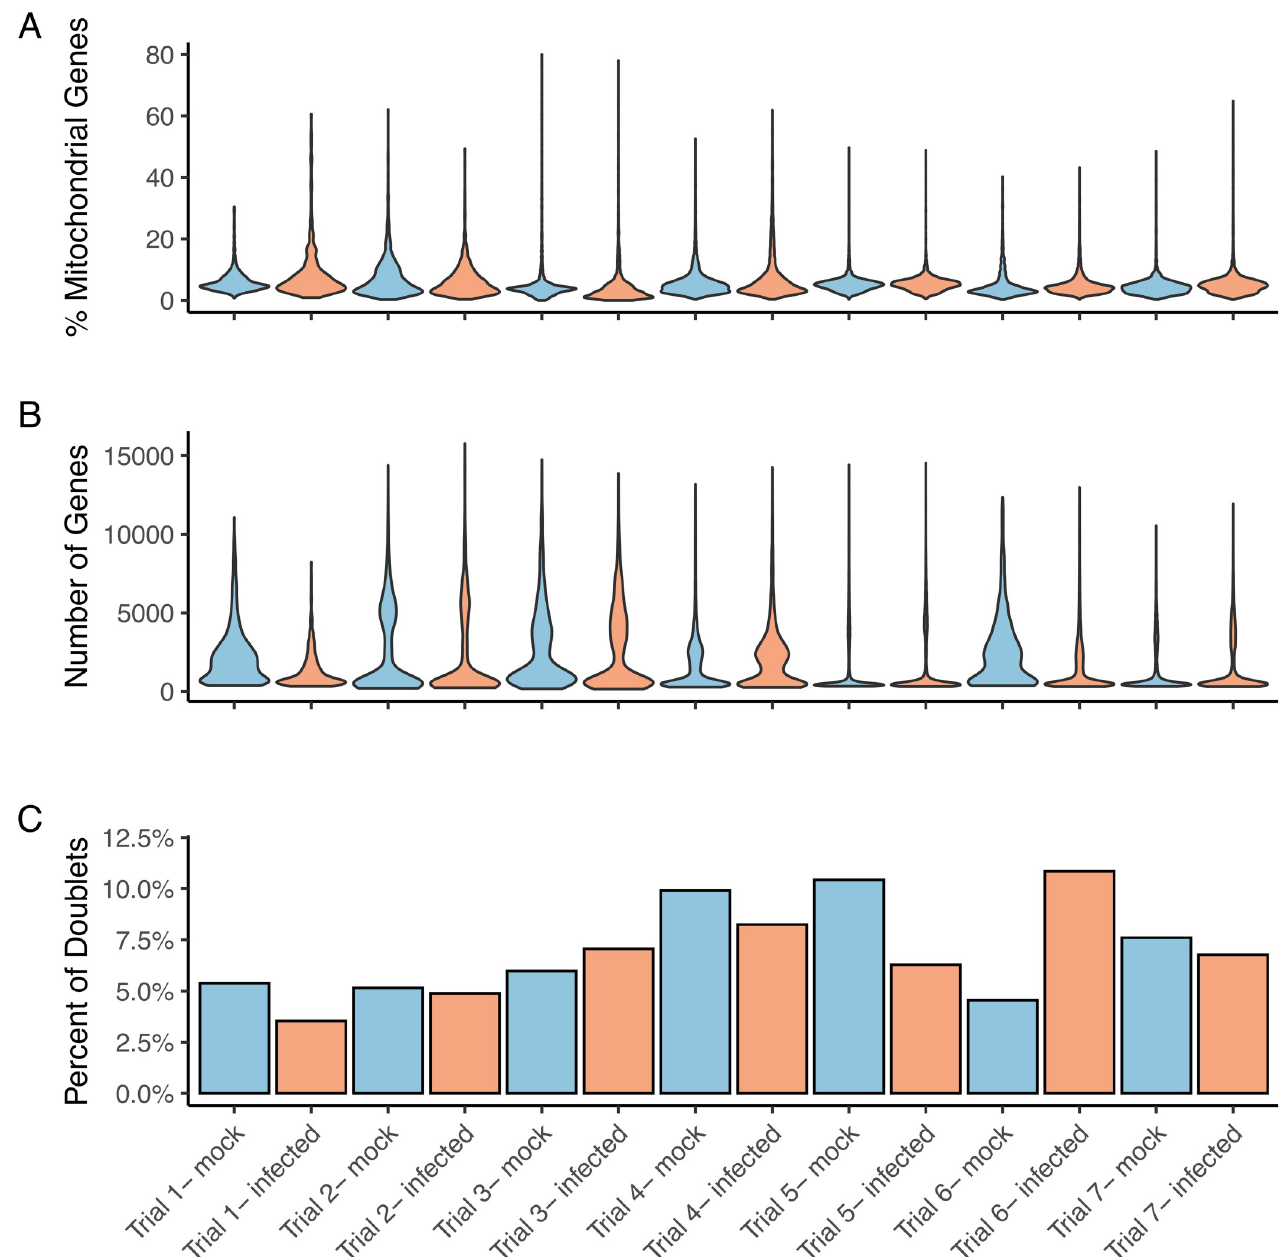
Fig 3. Quality assessment of scRNAseq data from primary lung epithelial cells. Seven independent cultures (“trials”) of primary human lung epithelial cells (each from a different donor) were differentiated on an air-liquid interface, and then infected with SARS-CoV-2 (“infected”; see Methods) or subjected to mock infection (“mock”). Cells were then fixed with methanol-acetone, and RNA isolated in the presence of an RNAse 1 inhibitor. RNA samples were then subjected to scRNAseq analysis, and assessed for common quality control metrics. (A) Violin plot depicting the percentage of mitochondrial genes in each cell. (B)Violin plot of log 10 normalized detected reads per cell. (C) Bar plot of doublet proportion for each sample.